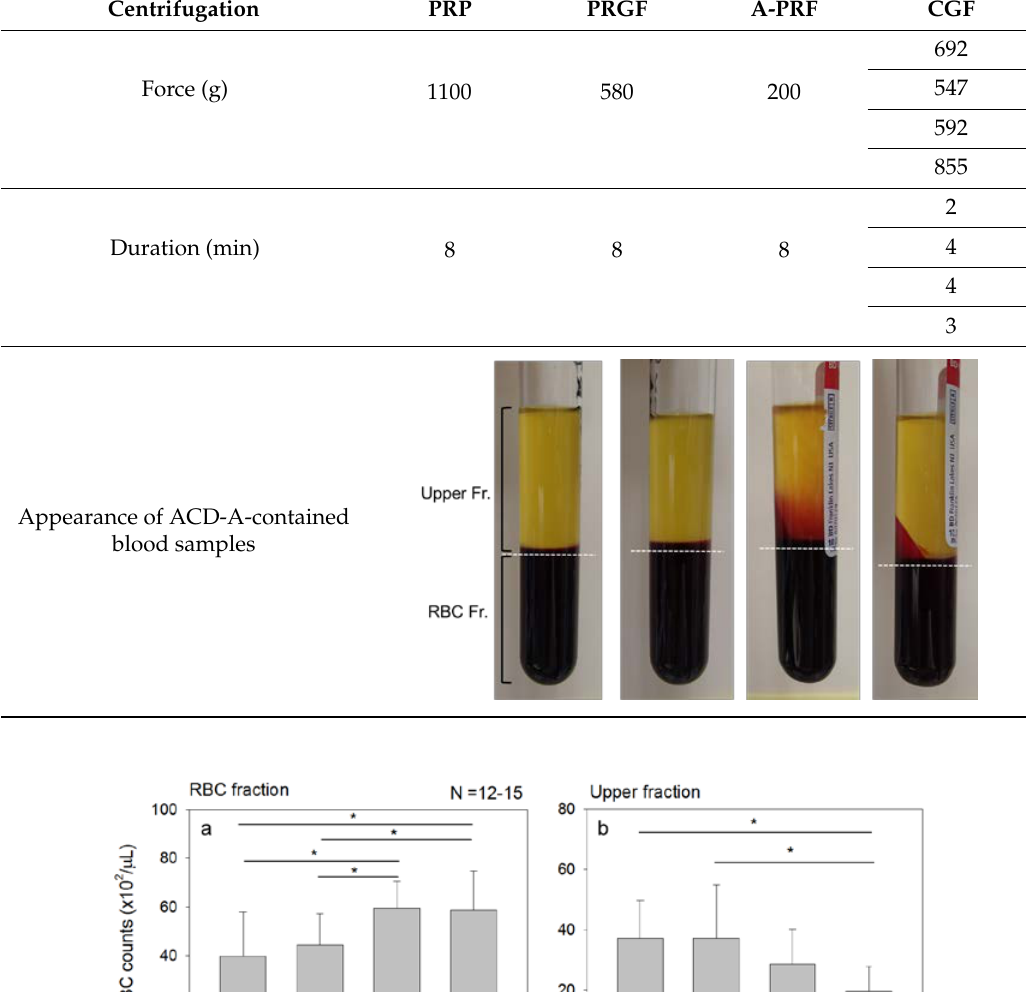
Centrifugal conditions for preparation of four platelet concentrate types and the resulting fractions.